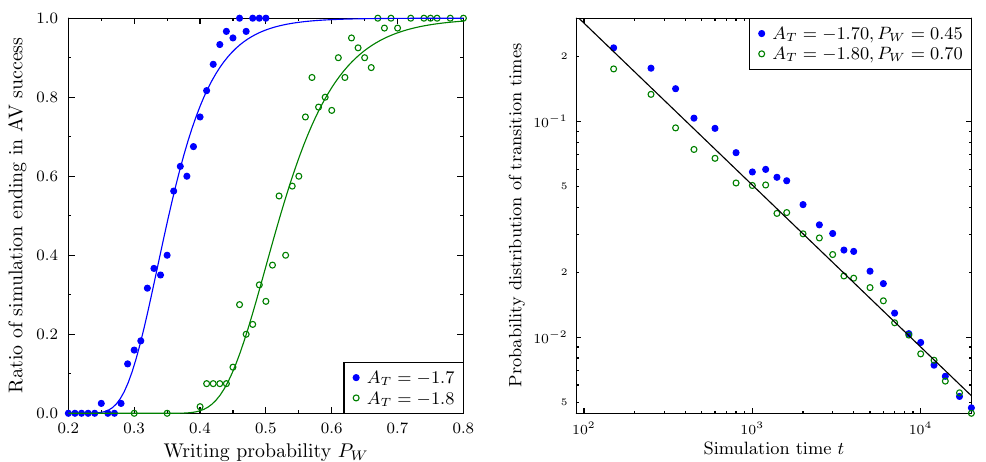
Figure 7. ( Left Panel ): Dependence of the ratio of simulation runs ending in AV campaign success within 20,000 time steps. Point sets correspond to simulations with different activism threshold A T . Lines are best fits using a logistic function. ( Right Panel ): Probability distributions for AV dominance transition times for two sets of parameters: A T = − 1.70, P W = 0.45, and A T = − 1.80, P W = 0.70, one thousand simulations for each group of parameter settings. Both cases correspond to situations where most of the simulations result in AV success within the 20,000 time steps limit. Note the log-log scale used. The distribution follows a power law with an exponent close to − 0.75 (black